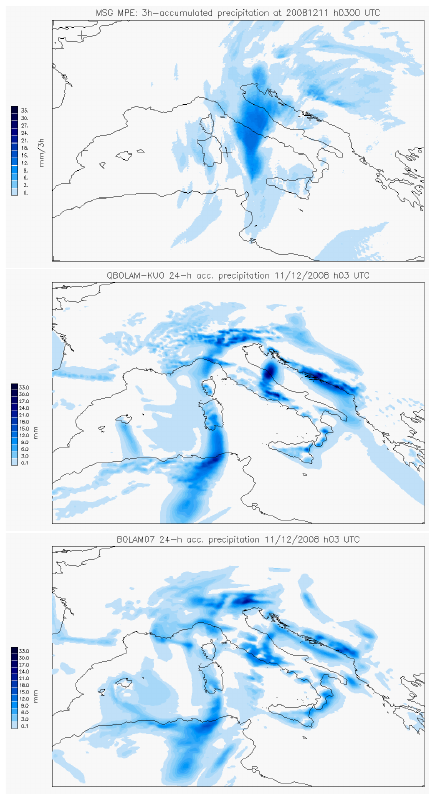
Fig. 6. 3h-accumulated precipitation at 0300 UTC 11 December 2008. Top: MPE; middle: QBOLAM; bottom: BOLAM 2007. In the MSG WV image for peak B, a high PV anomaly is visible as a dark tongue over the Balearic Islands (Fig. 7, top panel) and can be used to identify the position and the devel- opment stage of the cyclone (see blue dotted line in Fig. 7). For both model versions, the dark tongue shows an excessive concavity on its eastern flank (over Gulf of Lion). This can result from an excessive depth of the surface low on Genoa Gulf. Moreover, the African secondary cyclone is still vis- ible as a vorticity centre over Southern Tunisia (red dotted line); both the model versions tend to shift it north-easterly. tures seems not to be clearly reduced by the model upgrade. This is not the case for the mesoscale features: in fact, a light grey band – indicating moist, ascending air – is present